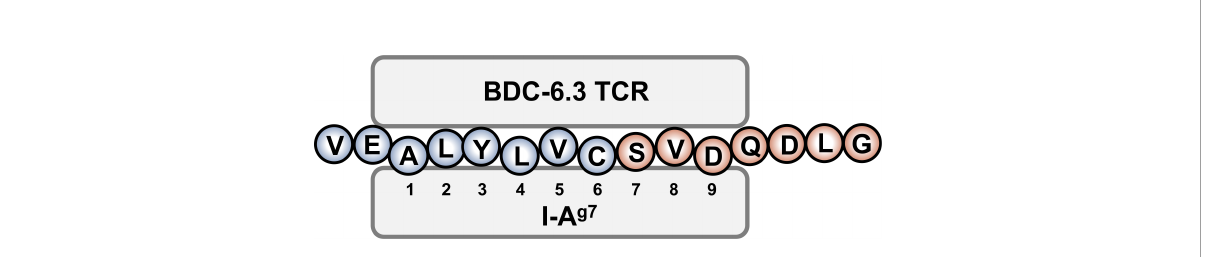
FIGURE 5 Schematic diagram of the 6.3HIP binding in the trimolecular complex. I-A g7 binding pockets 1, 4, and 6 are occupied by insB-chain amino acids 14 (A), 17 (L) and 19 (C), respectively. ProSAAS amino acids 219 (S) and 221 (D) residue in pockets 7 and 9 of I-A g7